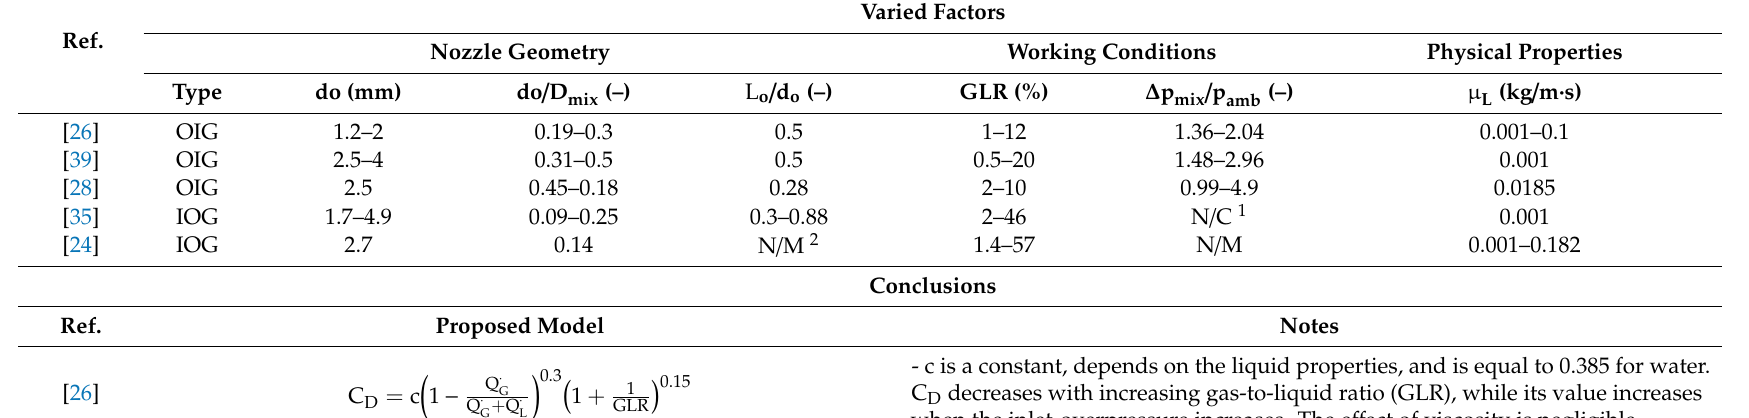
Table 1. Summary of the published discharge coe ffi cient (C D ) equations.